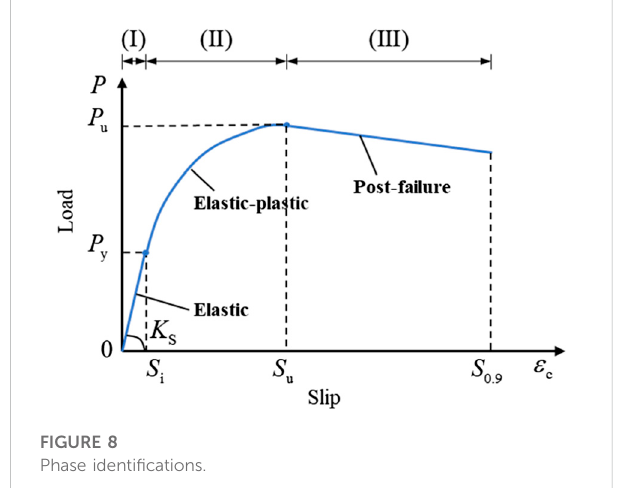
FIGURE 8 Phase identi fi cations.